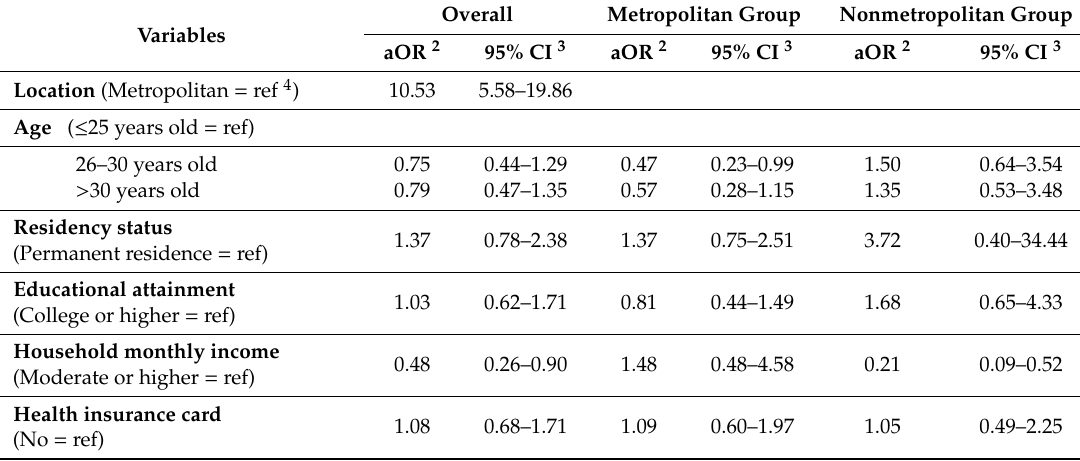
Table 4. Multivariable logistics for the intention to receive the HPV vaccine 1